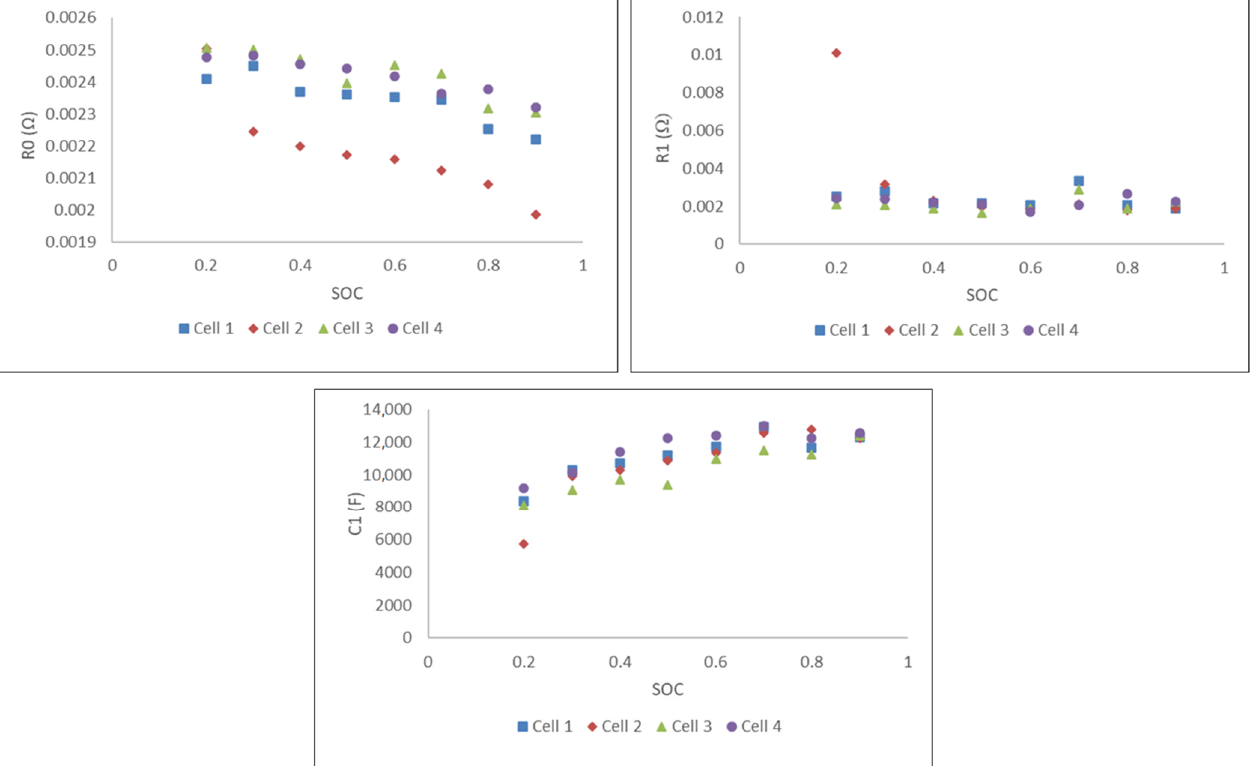
Figure 4. ECM parameters obtained from the HPPC tests: R 0 ( top left ), R 1 ( top right ), and C 1 ( bottom ).